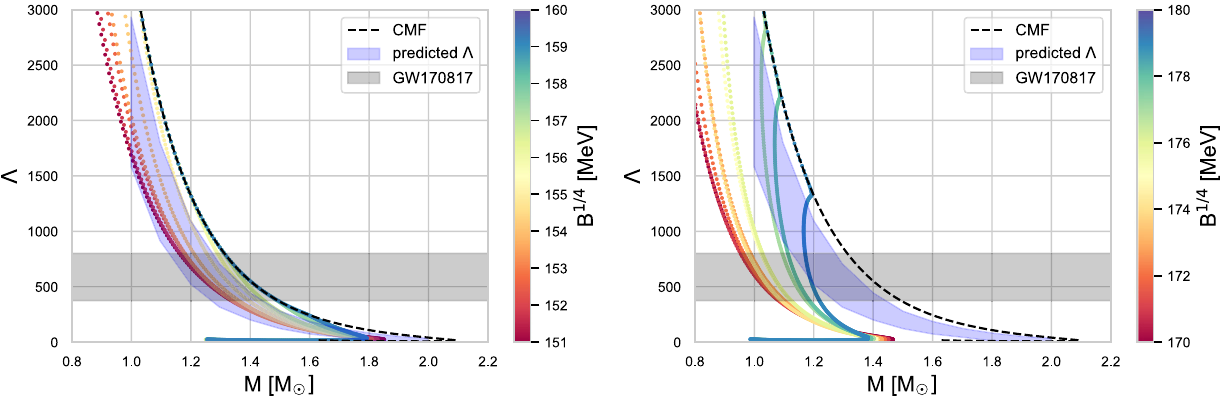
Fig. 5 Dimensionless tidal deformability parameter (cid:14) for the 2-flavor (left) and 3-flavor (right) Bag-CMF model. The blue shaded area is the prediction of a neutral network trained on observed neutron star masses and radii in [12]. The shaded horizontal interval is a 2 σ confidence bound 375 < (cid:14) 1 . 4M (cid:2) < 800 from Bayesian analysis based on the merger event GW170817 for a 1 . 4M (cid:2) NS [11]. The color indicates the